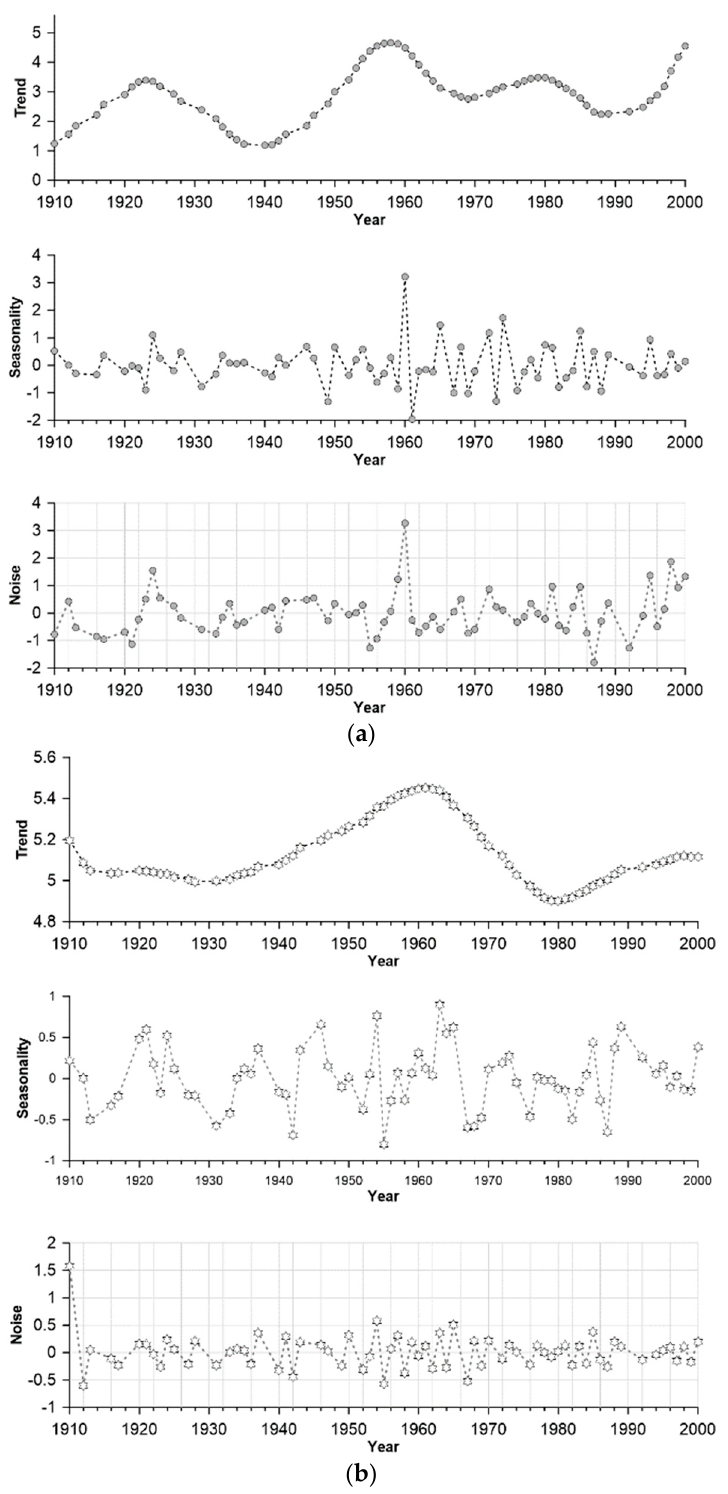
Figure 9. Trend, seasonality and noise components for the annual earthquake number ( a ) and maximum annual magnitude ( b ) series.